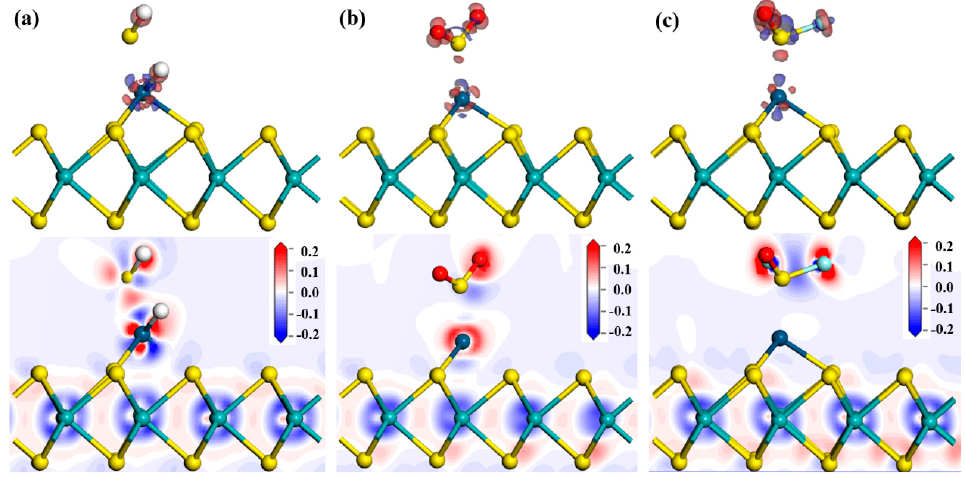
Figure 9. The DCD of ( a ) H 2 S-Ir-MoS 2 , ( b ) SO 2 -Ir-MoS 2, and ( c ) SOF 2 -Ir-MoS 2 adsorption systems.